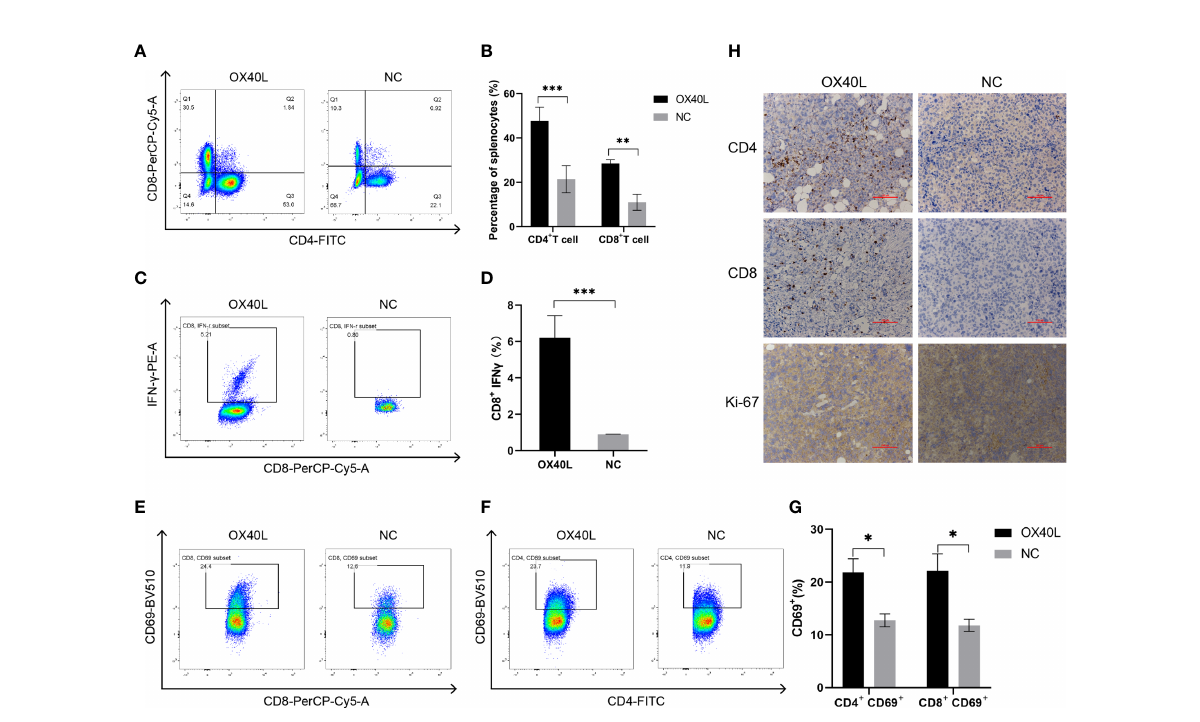
FIGURE 5 OX40L mRNA elicited lymphocyte activation in the H22 tumor bearing mice. (A, C) T-cell activation by fl ow cytometry. CD4 + T cells and CD8 + T cells in the spleen of the H22 tumor-bearing BALB/c mice. (B, D) Quantitative analysis of the proportions in (A , C) . Statistical signi fi cance